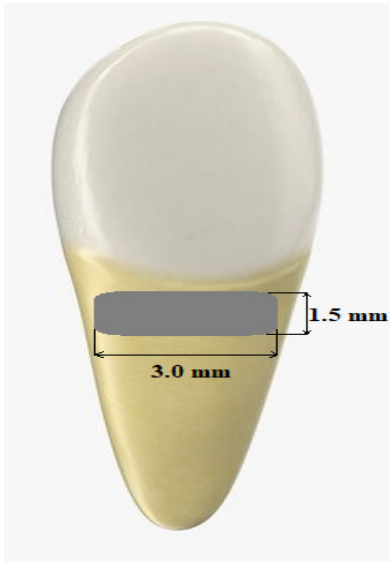
Figure 2. The image of a model preparation of the root surface in the cervical region.